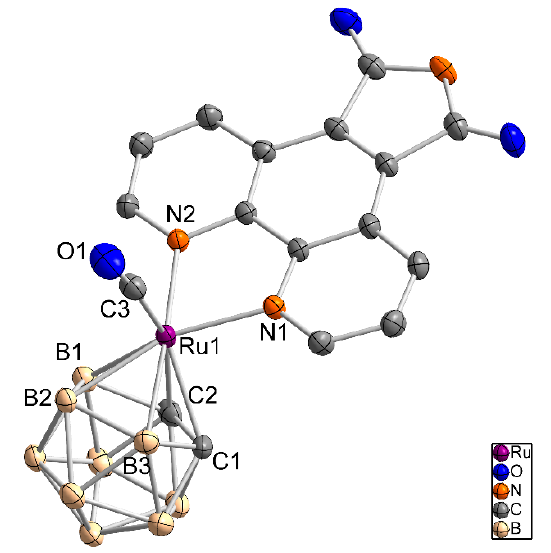
Figure 4. Molecule structure of [3-(CO)-3,3-{1 ′ ,10 ′ -NC 5 H 3 (C(CO)(NH)(CO)C)NC 5 H 3 - κ 2 N,N }- closo - 3,1,2-RuC 2 B 9 H 11 ] ( 5 ) as an ellipsoid-stick model with thermal ellipsoids at 50% probability level. Solvent molecules and hydrogen atoms are omitted for clarity.